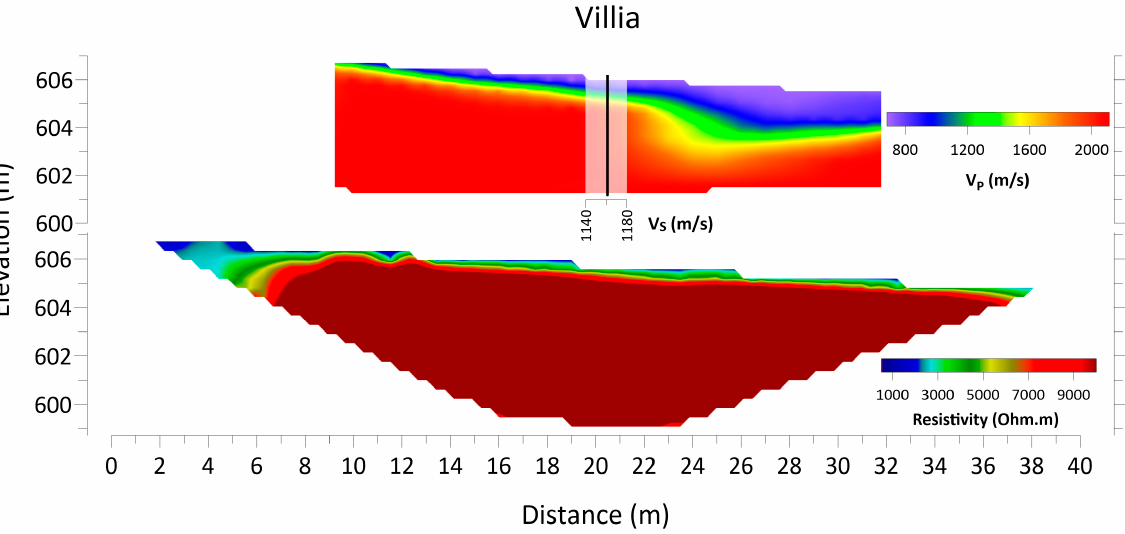
Figure 8. SRT and MASW ( top ) and ERT ( bottom ) sections at the site of the seismological station VILL .